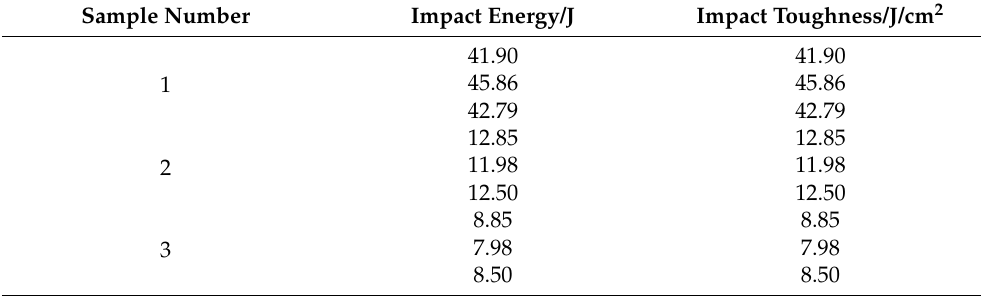
Table 6. Impact test results.